Question: Condense the content of this figure into a single sentence.
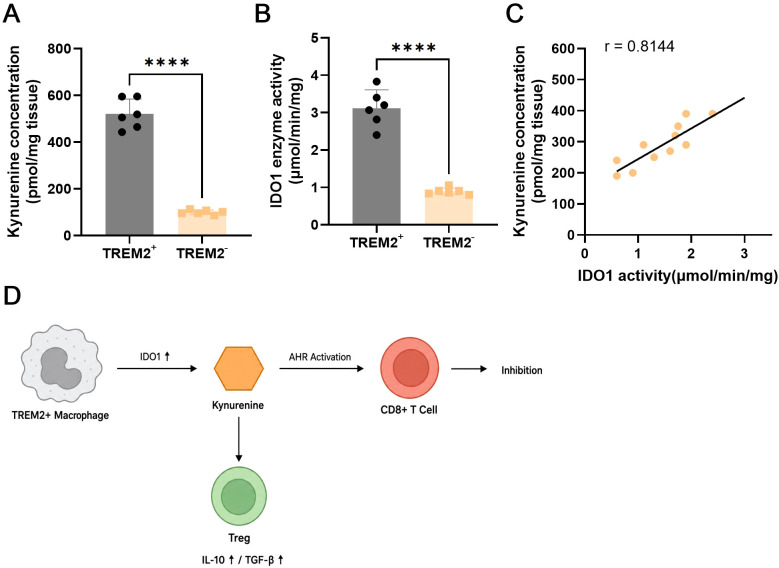
Answer: Activation of the Kyn metabolic pathway in TREM2 + macrophage-enriched regions. (A) Quantification of Kyn concentration in tissue samples by LC-MS/MS; (B) enzymatic assays comparing IDO1 activity in TREM2 + versus TREM2- regions; (C) Spearman correlation analysis between IDO1 enzymatic activity and Kyn concentration; (D) schematic model of the IDO1-Kyn metabolic axis, illustrating how TREM2 + macrophages upregulate IDO1 activity to enhance Kyn synthesis, thereby contributing to CD8 + T cell suppression and immune exhaustion. Each group consisted of six animals; experiments were repeated three times. **** p < 0.0001.